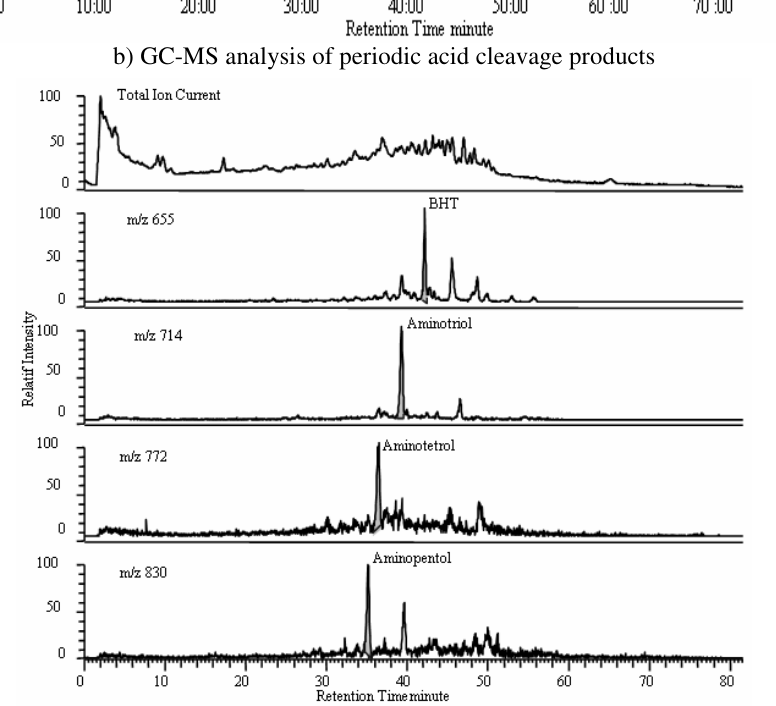
Figure 6. Lake Voua de la Motte-anoxic zone